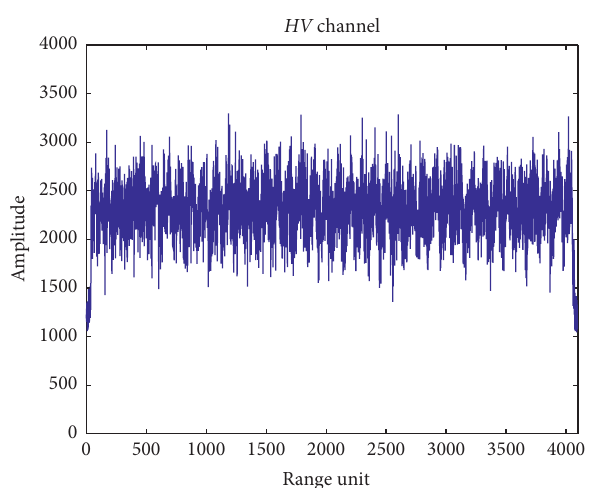
Figure 8: Echo signal received by horizontal polarization sum channel with active blanket jamming.